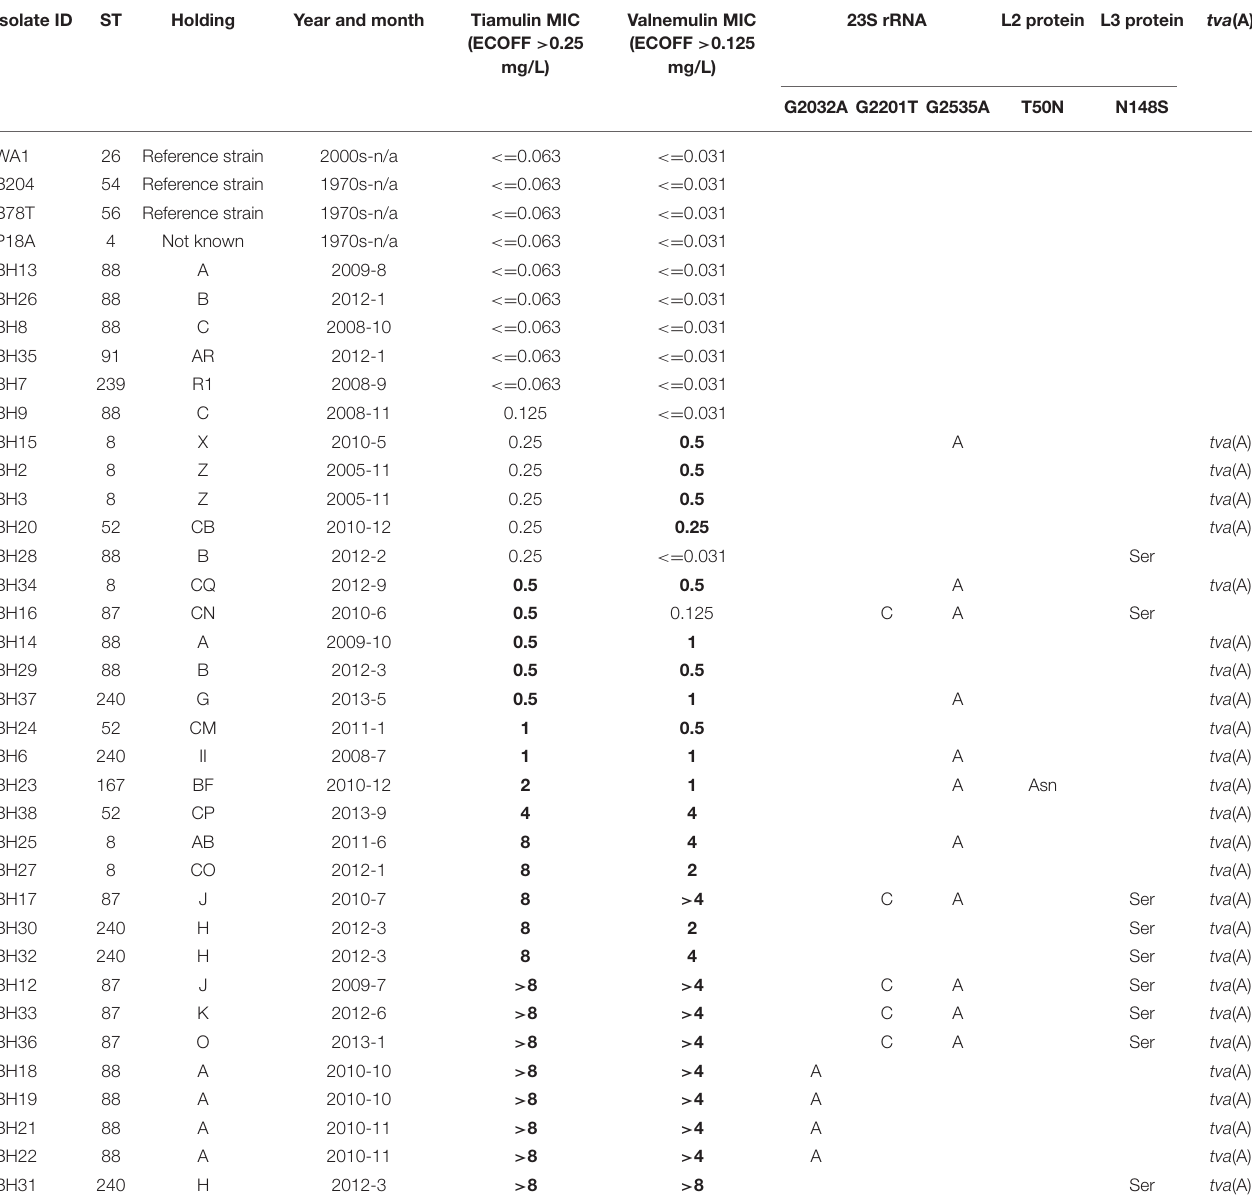
TABLE 1 | Summary of the 34 field isolates and three reference strains examined in this project, sorted by tiamulin Minimum Inhibitory Concentration (MIC). Isolate ID